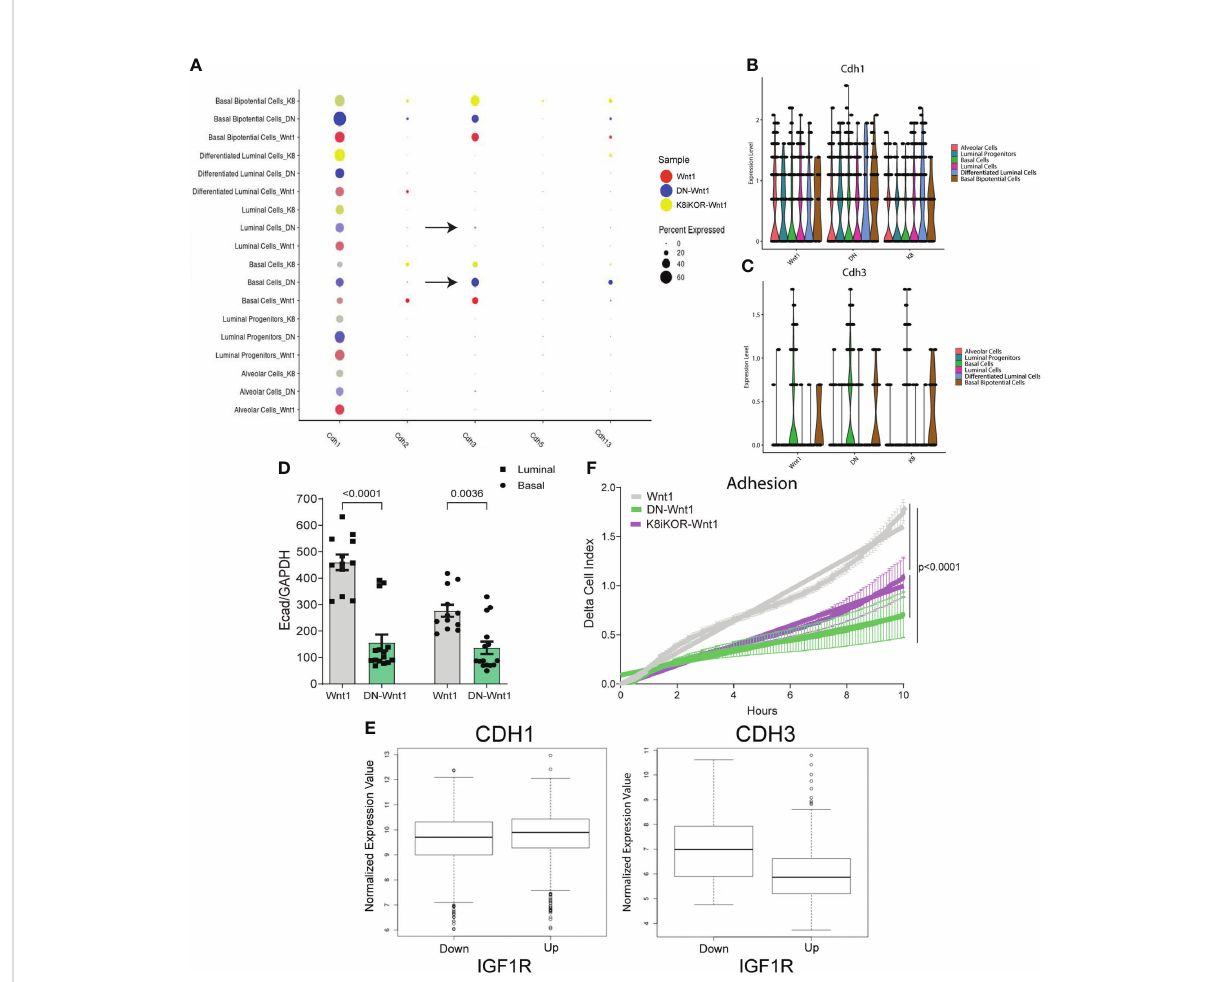
FIGURE 7 Reduced IGF1R function decreases tumor cell adhesion. (A) Dot plot of various cadherins expressed in epithelial tumor cell clusters. Arrows depict clusters with an increase in P-cadherin in the DN-Wnt1 tumors. (B, C) E-cadherin (B) and P-cadherin (C) expression in annotated epithelial cell types identi fi ed with single-cell sequencing in Wnt1, DN-Wnt1, or K8iKOR-Wnt1 primary tumors. (D) RT-PCR for E-cadherin from Wnt1 or DN-Wnt1 sorted luminal and basal epithelial tumor cells. Statistic: Non-parametric Mann-Whitney U test. (E) METABRIC data analysis for E-cadherin or P-cadherin in patient tumors with low IGF1R (IGF1R z-score < -1) or high IGF1R (IGF1R z-score > 1) (p < 2.0x10 -16 ) Statistic: Student ’ s t -test. (F) Measurement of adhesion from Wnt1 (grey), DN-Wnt1 (green), or K8iKOR-Wnt1 (purple) by delta cell index over time for 6 hours using the real-time xCELLigence assay. n=3; Statistic: Non-linear regression least squares regression for slope best fi t p<0.0001 for Wnt1 control compared to DN-Wnt1 or